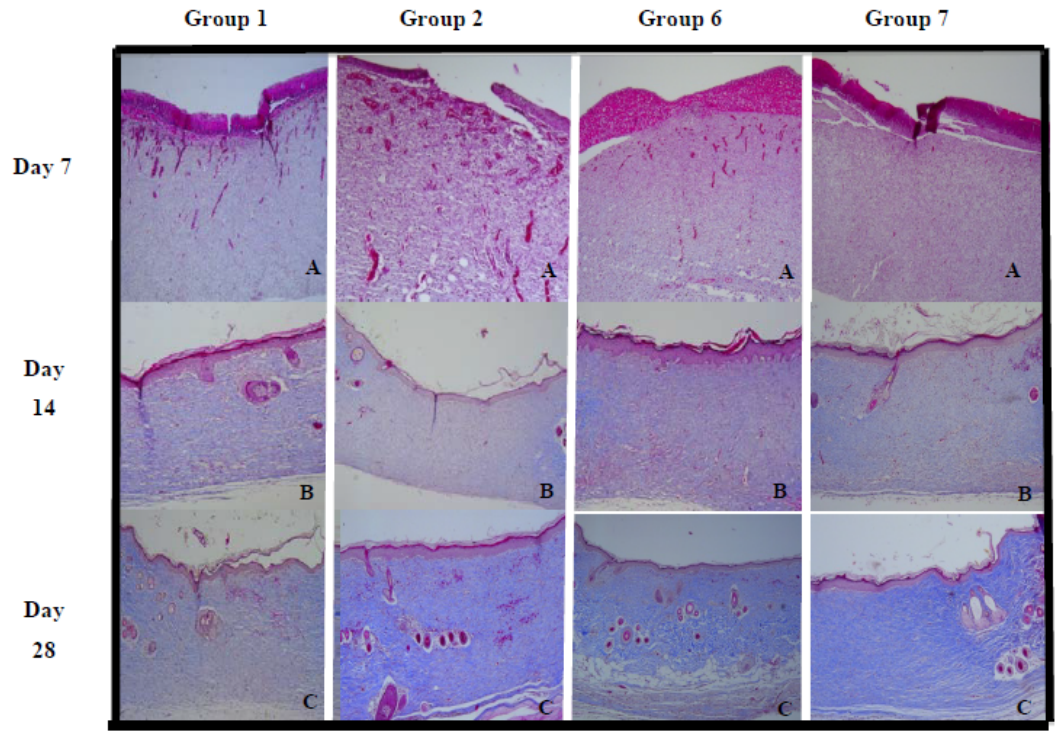
Figure 3. Evidence of collagen deposition on wound for animals treated with mahanimbicine (G2) and extract (G6) along with wound treated with standard ointment (G7) and untreated wound (G1).